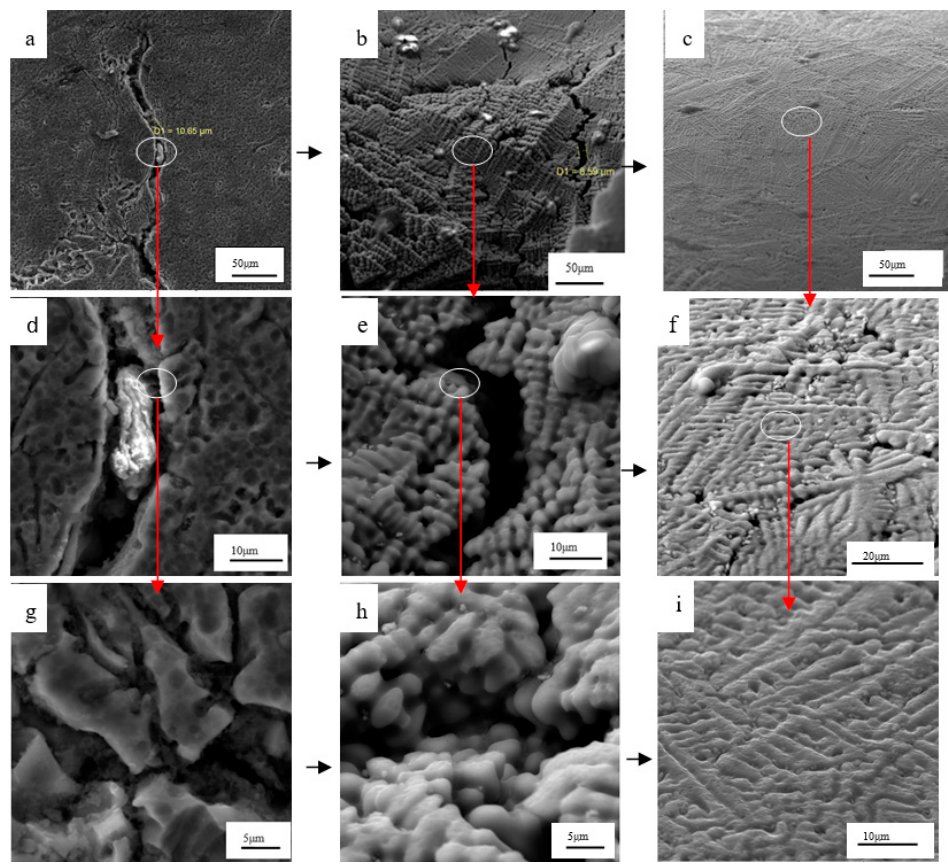
Figure 6 . Influence of wire feeding speed on the microstructure near the solidification cracks: ( a , d , g ) 4.5 m/min; ( b , e , h ) 6 m/min; ( c , f , i ) 7 m/min.